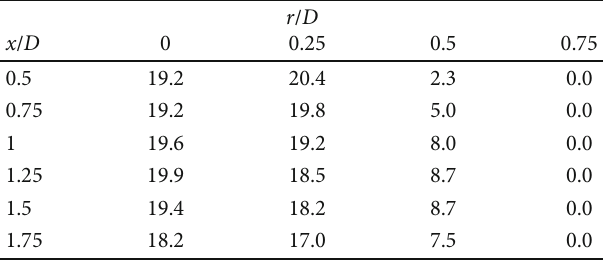
Figure 1: The body- fi xed reference frame of Egretta. Table 1: Egretta time-averaged propeller slip- fl ow speed (m/s) at RPM = 6400